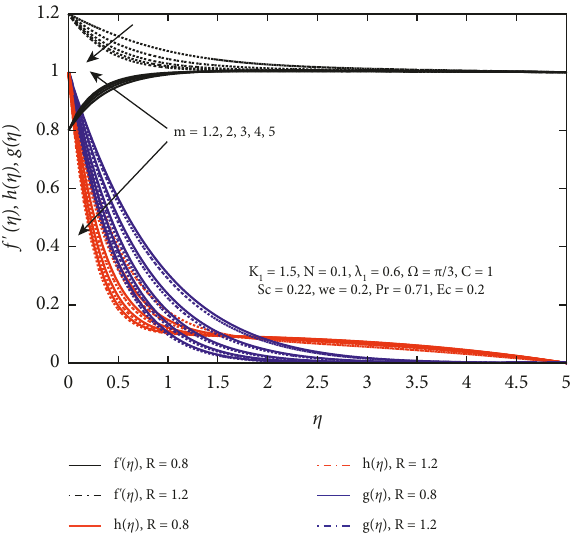
, h ,g η η η for increasing values of m. ( ) ( ) ( ) ′